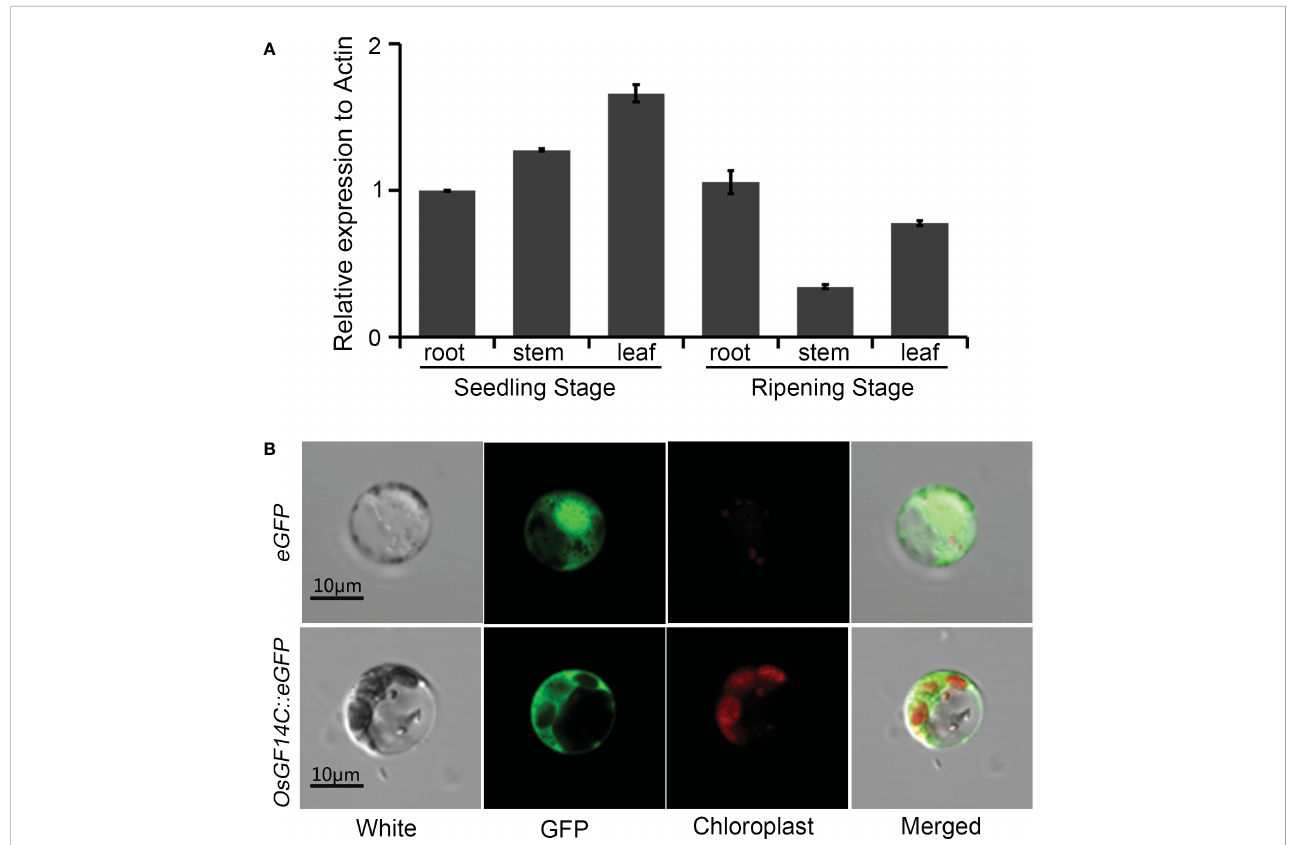
FIGURE 4 The temporal and spatial expression patterns of OsGF14C and its subcellular localizations. (A) Expression analysis of OsGF14C in different rice tissues by quantitative real-time PCR. Error bars indicate the standard deviation (SD) from three biological replicates; (B) Sub-cellular localization of OsGF14C in rice protoplasts. White indicates the protoplast under visible light, GFP indicates the eGFP fl uorescence, Chloroplast indicates the chloroplast fl uorescence, Merge indicates the overlapping situation of White, GFP, and